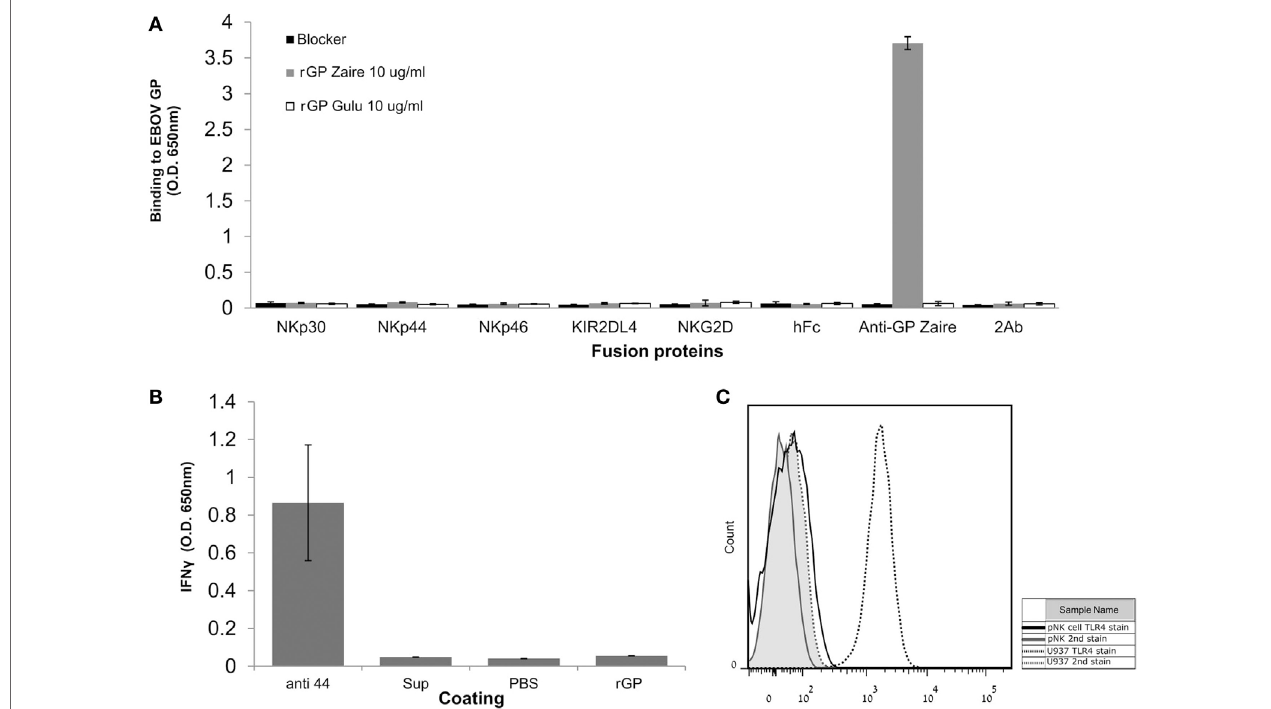
FigUre 1 | Natural killer (NK)-cell-expressed receptors do not interact directly with EBOV-GP. (a) ELISA plates were coated with either soluble recombinant Sudan virus (SUDV)-GP (Sudan ebolavirus GP) or Zaire ebolavirus GP and incubated with fusion-Ig, anti EBOV-GP monoclonal antibody (mAb), or PBS to assay for direct interaction. Fusion-Ig was detected with horseradish peroxidase-conjugated anti-human IgG. (B) Plastic wells were coated with either anti-NKp44 activating mAb, soluble recombinant SUDV-GP, medium preconditioned with GP-expressing cells (“sup”), or PBS and incubated with pNK cells in the presence of 25 U/ml rhIL-2. The culture media were sampled, and IFN γ was quantified using an ELISA assay. (c) Primary NK was stained with phycoerythrin-conjugated anti-human TLR4. As a positive biological control, U937 cells that express TLR4 were stained too. Results are from one representative experiment of three (a) and two (B,c) performed. Values represent means of triplicates; Bars, ±